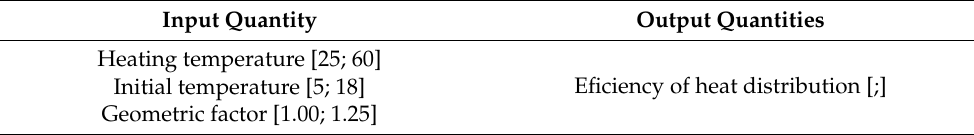
Table 1. Summary of input and output values within the framework of an incomplete experiment